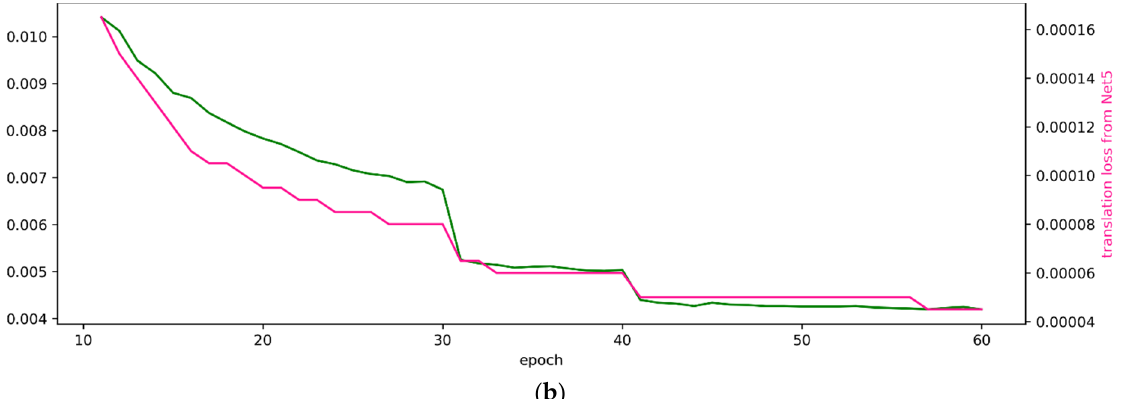
Figure 8. Changes in calculated losses during Net1 and Net5 training on the Oxford dataset. ( a ) Rotation loss L rot calculated using Equation (10). ( b ) Translation loss L trs calculated using Equation (11).